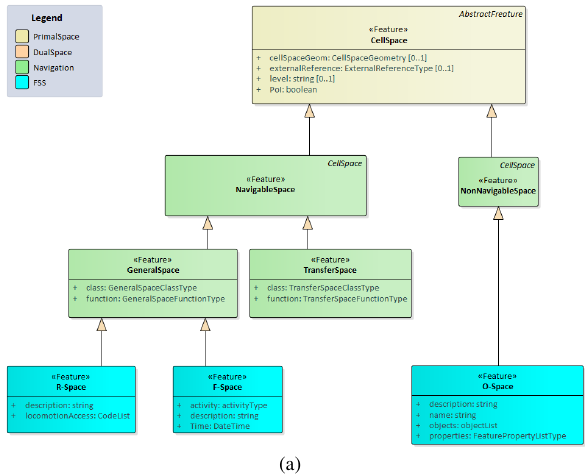
Figure 3. UML diagrams of the FSS integration to the Navigation